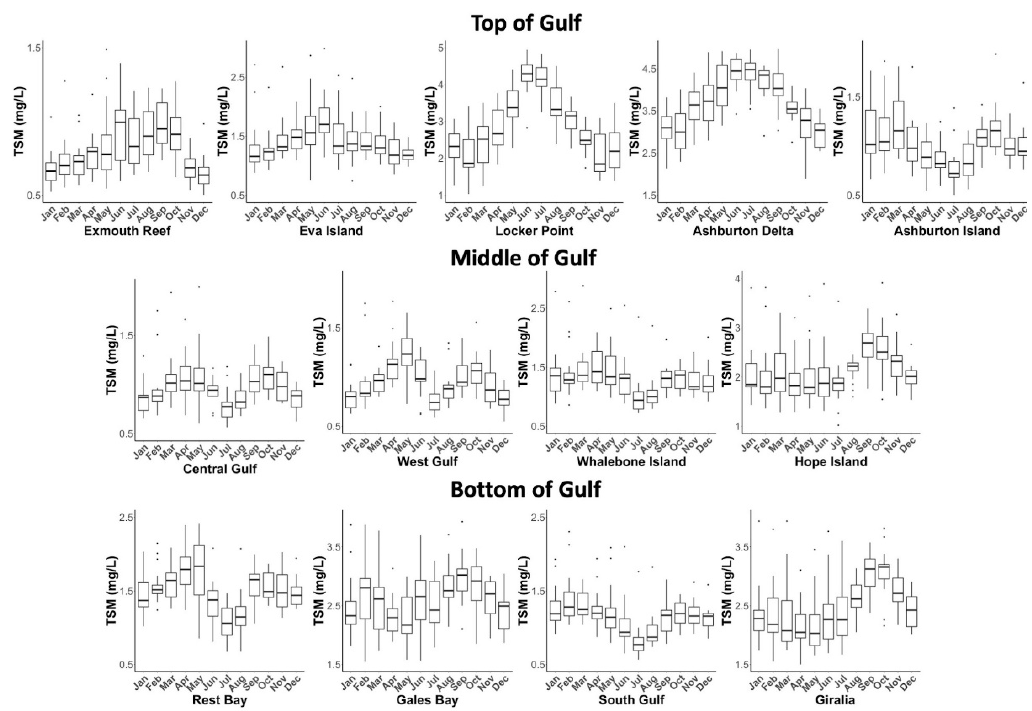
Figure 5. Monthly differences in average turbidity (TSM mg/L) from 13 different locations in the Exmouth Gulf 2002–2020. Spectral analysis of daily TSM supports the observed seasonal turbidity trends. For example, those sites experiencing a single winter TSM peak return a very strong spectral frequency of 360 days while sites that experience autumn and spring peaks returned a spectral analyses frequency spike at 180 days. Sites located in the southern Gulf, including Giralia, Hope Island, Gales and Rest Bay were also found to exhibit a spectral frequency spike at 14 days, coinciding with the spring–neap tidal period (Figure 6).